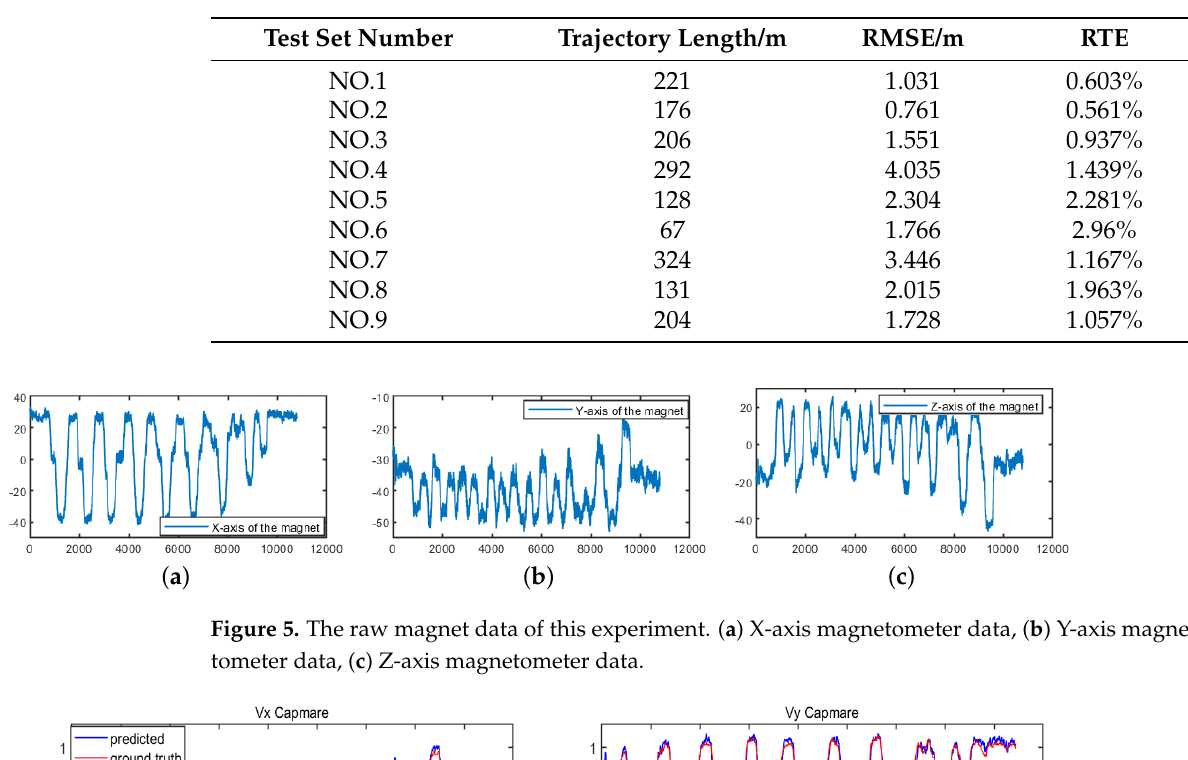
Table 2. Evaluation indexes of part of the test set.